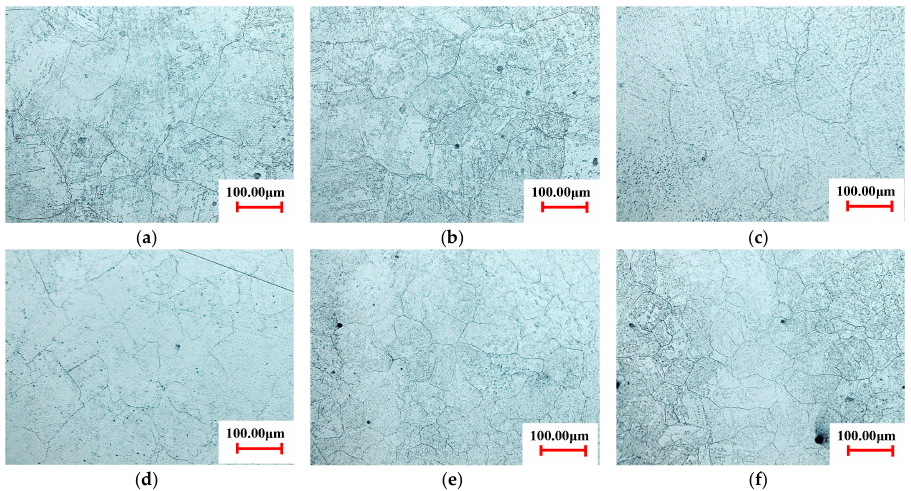
Figure 3. Microstructure of sample A at the interruption strain of 0.151 and different holding times: ( a ) 0 s; ( b ) 5 s; ( c ) 50 s; ( d ) 120 s; ( e ) 200 s; ( f ) 600 s.